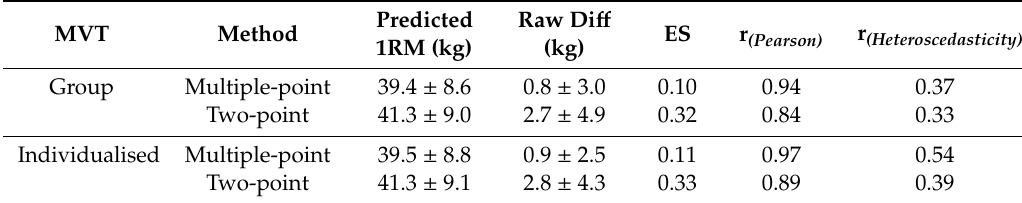
Table 1. Differences, associations and heteroscedasticity of the errors between the actual and predicted one-repetition maximums (1RM) during the bench press exercise. MVT